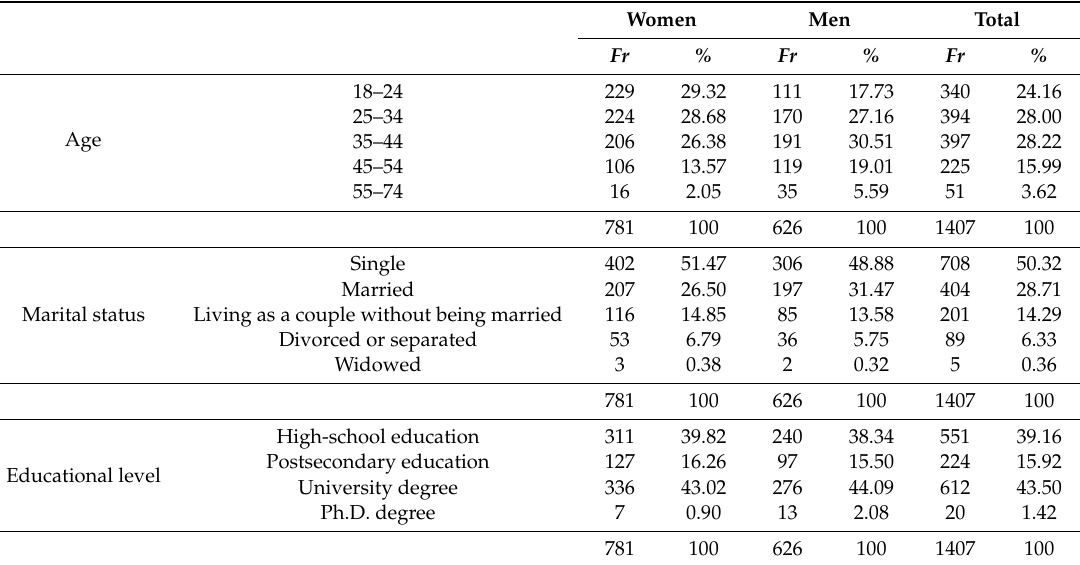
Table 1. Sociodemographic characteristics of the